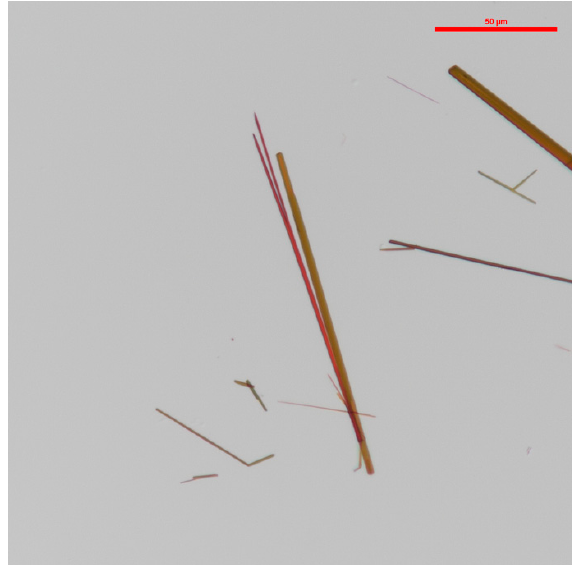
Figure 2. Red and orange coloration of the crystals produced by the pigment of S. cuboideum . Image obtained with a Nikon Eclipse Ni-U at a magnification of 20×.